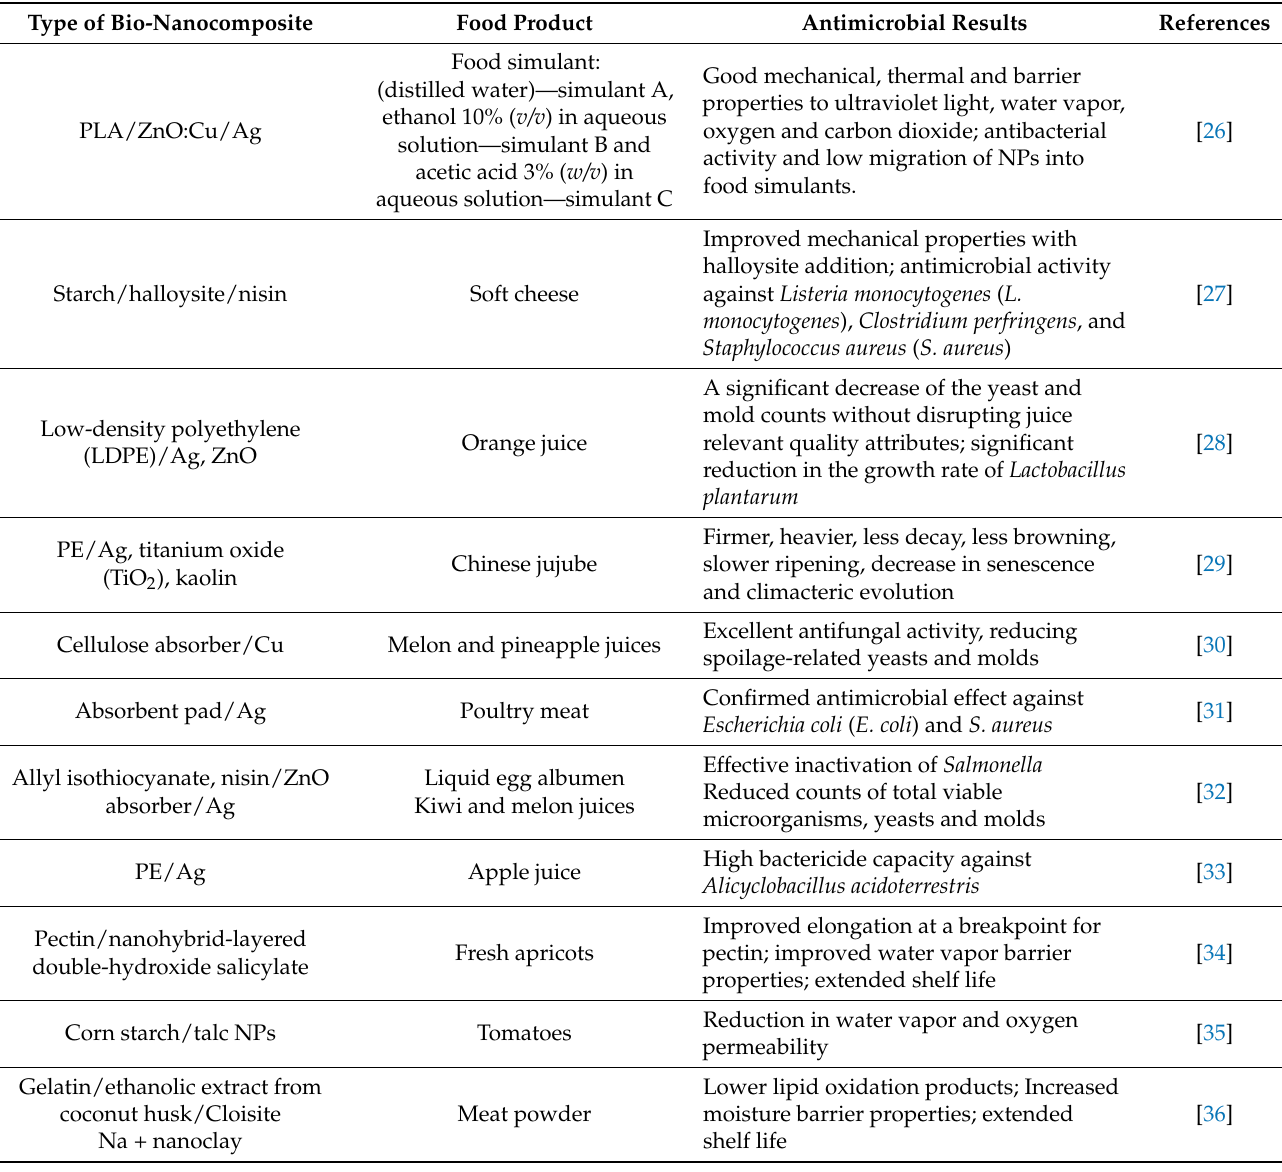
Table 1. Different types of antimicrobial bionanocomposites in food packaging